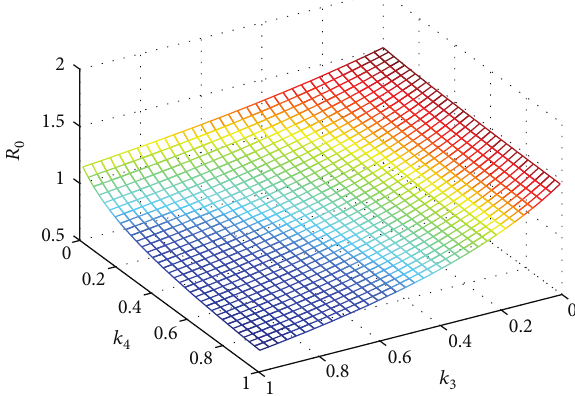
Figure 5: The relationship among 𝑅 0 , 𝑘 3 , and 𝑘 4